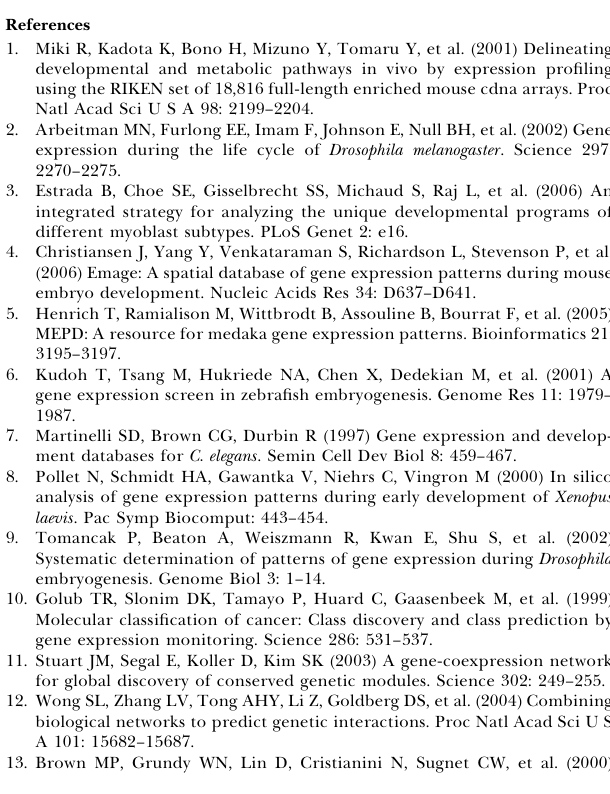
Table S9. De Novo Prediction of Localization of Expression for the tma2smusclep Functional Unit A 30% fraction of genes are characterized with high prediction scores. Table S10. De Novo Prediction of Localization of Expression for the pep2ebrain Functional Unit A 30% fraction of genes are characterized with high prediction scores. Table S11. De Novo Prediction of Localization of Expression for the vna2lcord Functional Unit A 30% fraction of genes are characterized with high prediction scores. Table S12. De Novo Prediction of Localization of Expression for the aep2egut Functional Unit A 30% fraction of genes are characterized with high prediction scores. Table S13. Number of Genes Simultaneously Attributed to Two Functional Units Encompassing Developmental Processes in Late Embryogenesis Table S14. Diversity of Anatomical Annotations of Genes Comprising the Functional Unit mat2pep Table S15. Diversity of Anatomical Annotations of Genes Comprising the Functional Unit tma2smusclep Table S16. Diversity of Anatomical Annotations of Genes Comprising the Functional Unit vna2lcord Found at doi:10.1371/journal.pcbi.0030144.st016 (105 KB PDF).